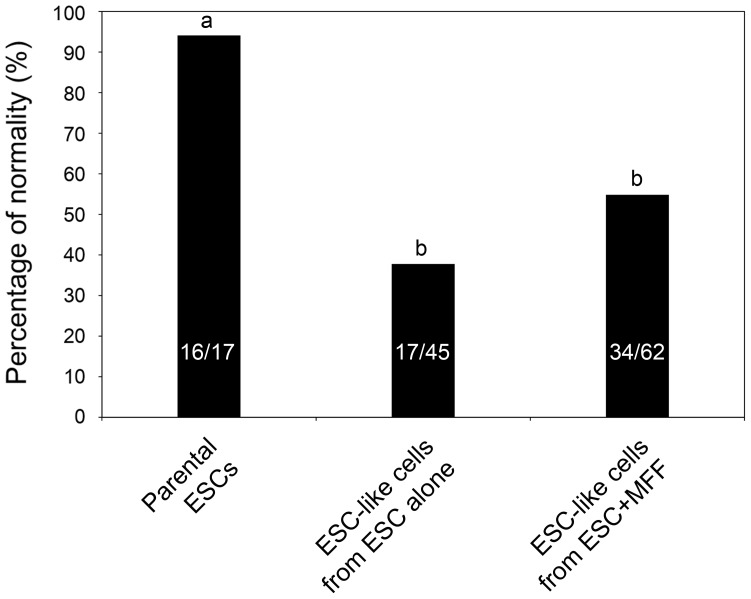
Chromosome normality of repopulated embryonic stem cell (ESC)-like cells after co-injection of ESCs and somatic cells.The normality was compared between parental ESCs and ESC-like cells repopulated from teratomas. PROC-GLM in SAS detected remarkable decreases of chromosome normality in all ESC-like cells repopulated compared to parental ESCs (p = 0.0003). The numbers within bars indicate the number of normal cells/the number of total cells counted. Different lettersa,b indicate significant difference among the groups, p<0.05.